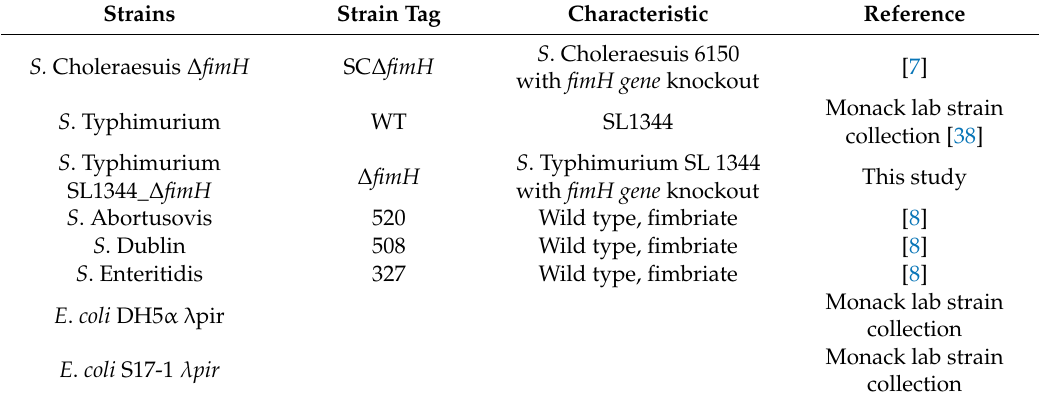
Table 1. Bacterial strains used in this study.